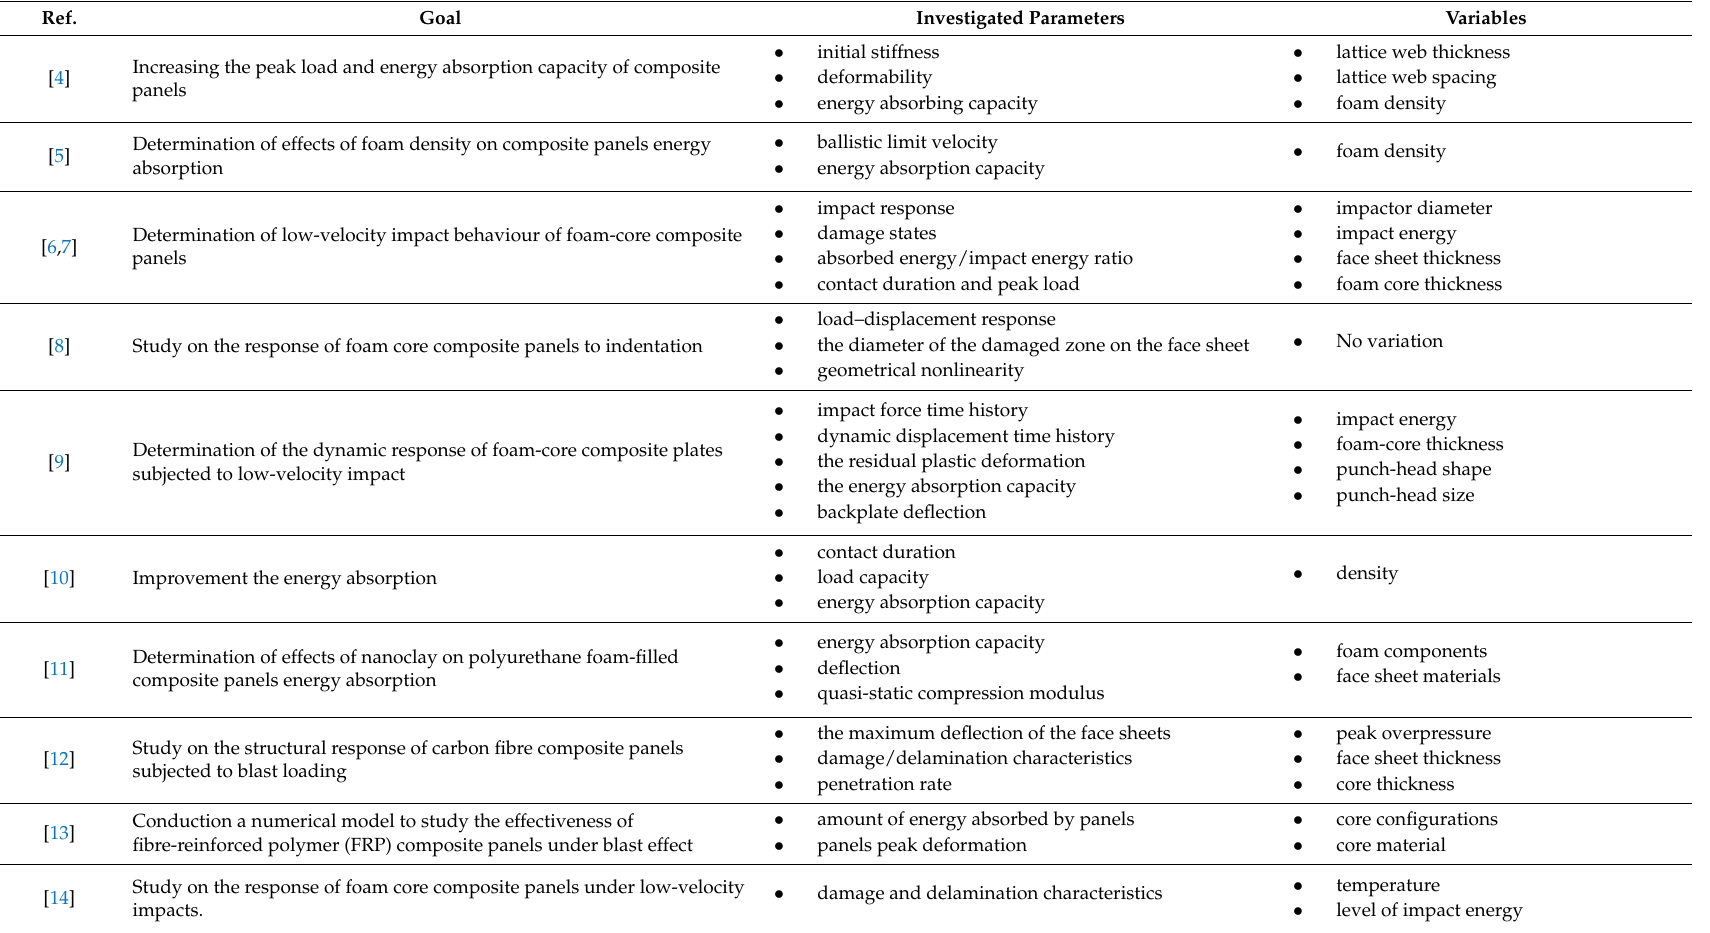
Table 1. Summary of the critical literature of energy absorption and dynamic behaviour.